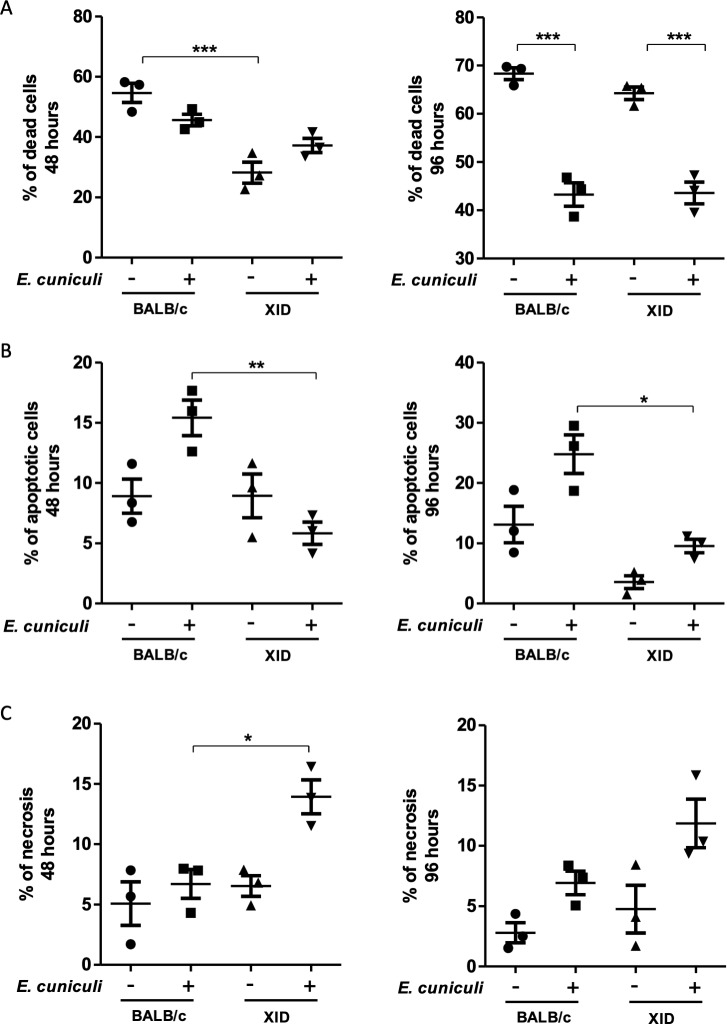
Necrosis and apoptosis of BALB/c and XID APerC cultures at 48 and 96 h.Percentual of: (A) death cells. (B) apoptotic cells. (C) necrotic cells. The data are presented as mean ± SEM (*P < 0.05, ** P < 0.01, *** P <0.001, One way ANOVA with Tukey post-test).